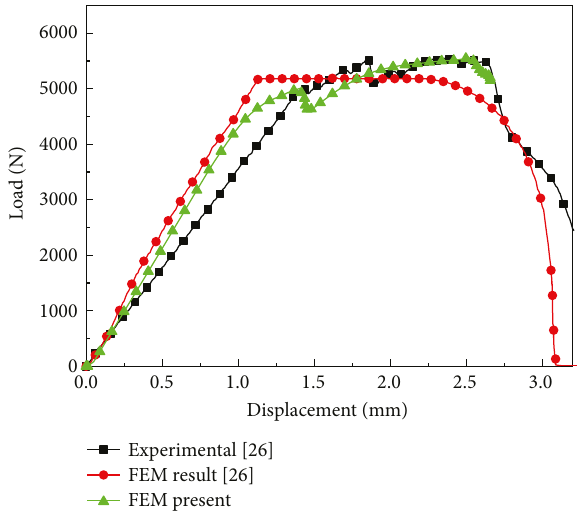
Figure 5: (a) Adopted fi nite element discretization including delamination area (zone I) and propagation area (zone II and zone III). (b) The boundary conditions of the composite laminate.